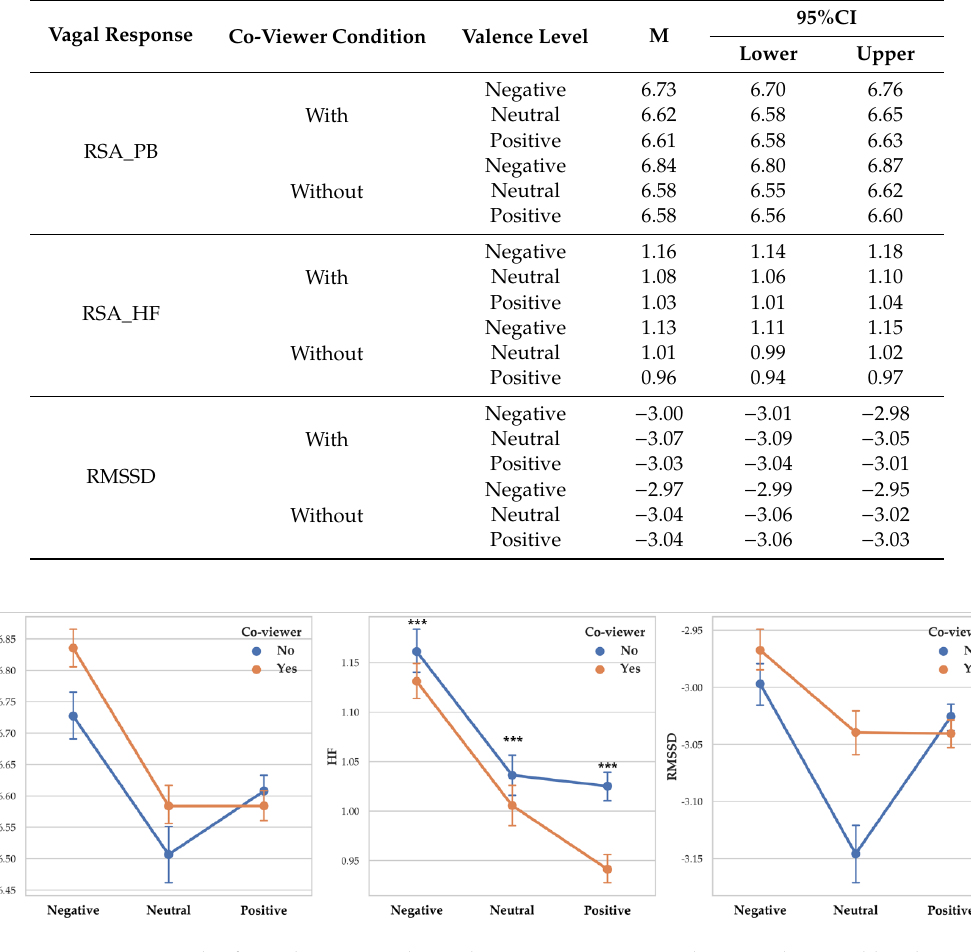
Table 14. Descriptive statistics for vagal response depending on existence of co-viewer and valence.